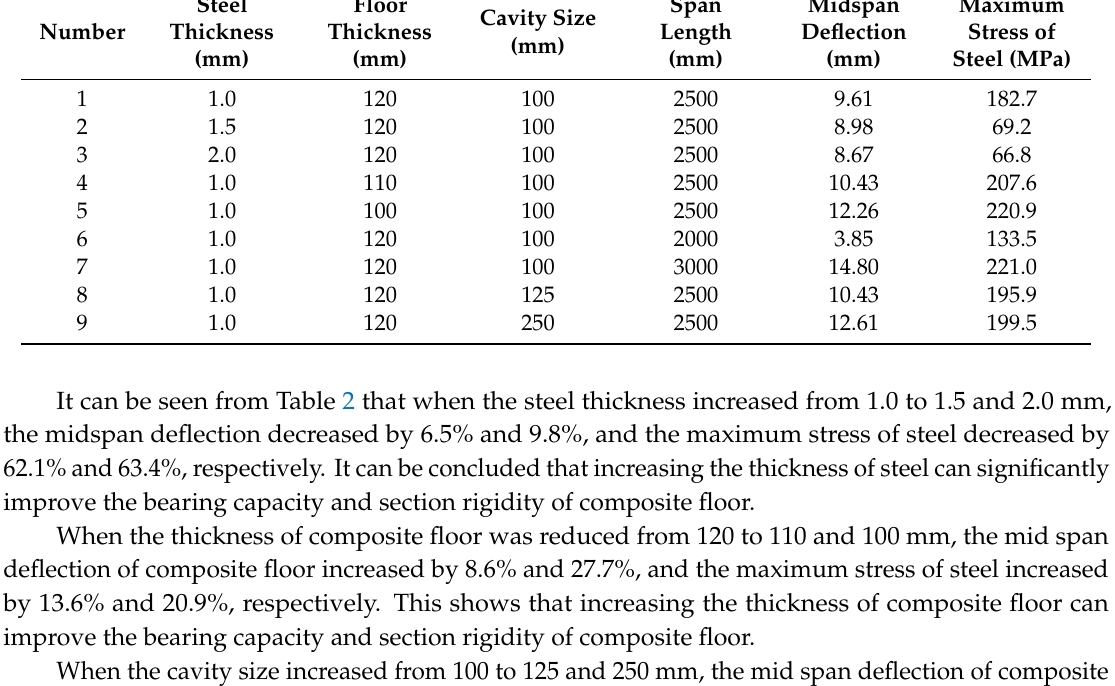
Figure 24. Stress nephogram of composite floor with different span: ( a ) 2500, ( b ) 2000 and ( c ) 3000 mm.